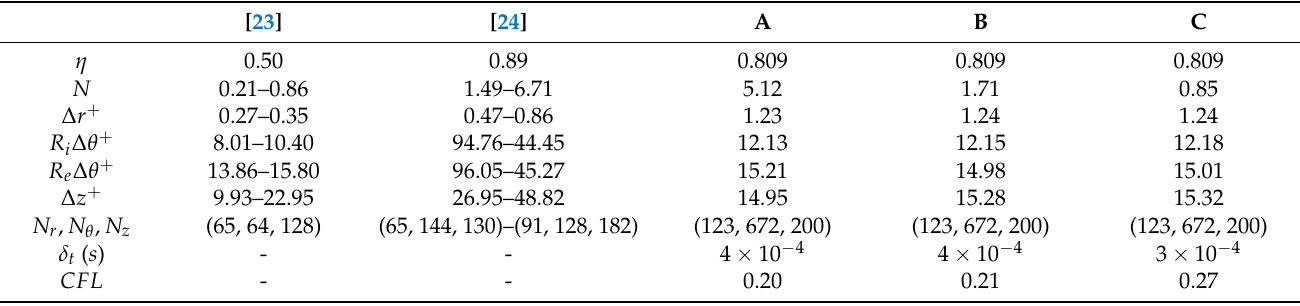
Table 2. Parameters of the numerical simulations used in LES.